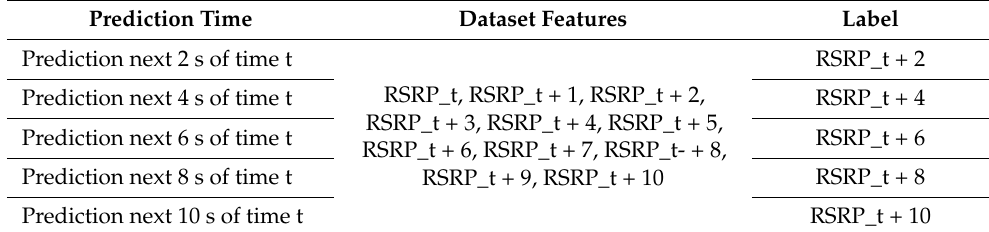
Table 5. The features for the training dataset. Table 6. Deep learning model